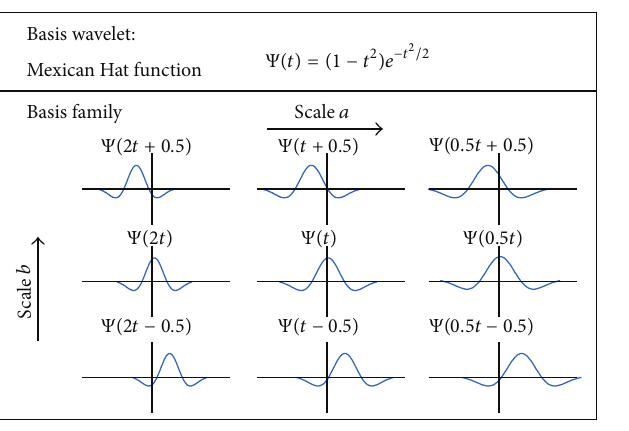
Figure 5: Wavelet building set based on Mexican Hat